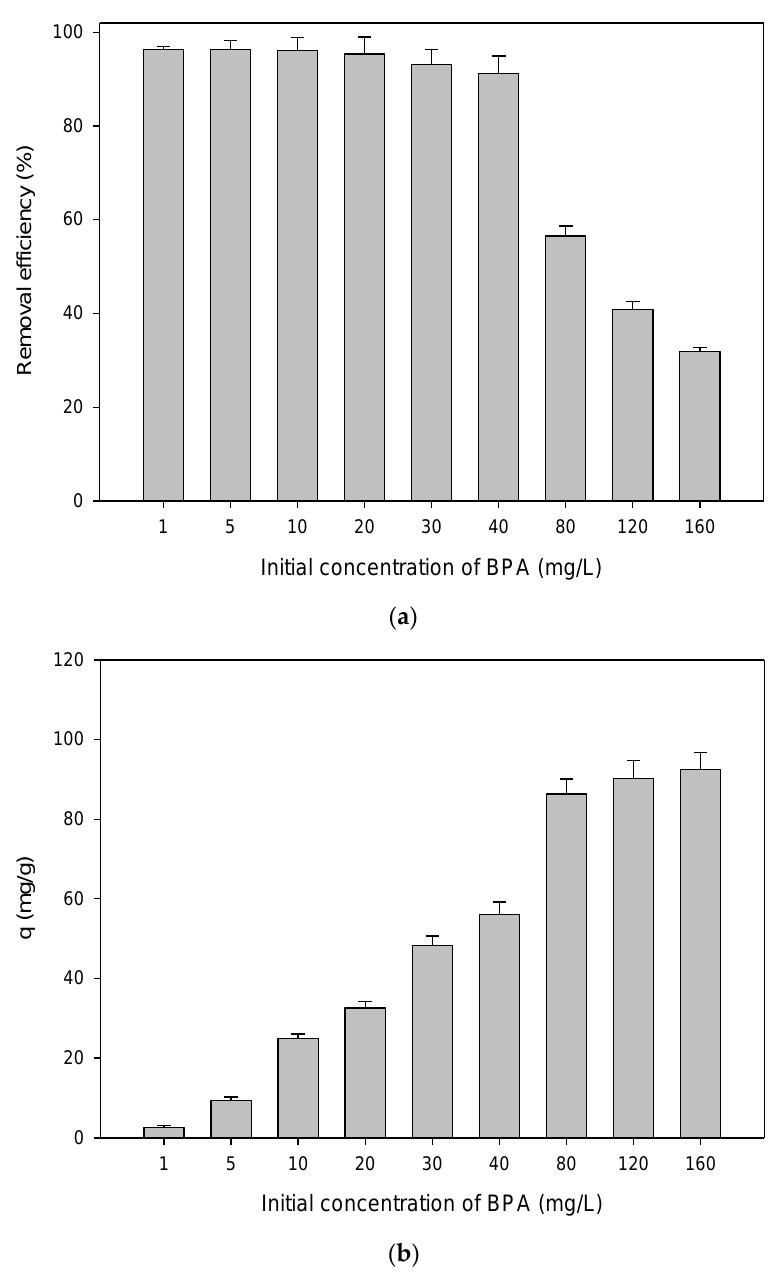
Figure 4. ( a ) BPA removal efficiency and ( b ) amount of BPA adsorbed by gram of activated carbon depending on initial concentration of BPA.